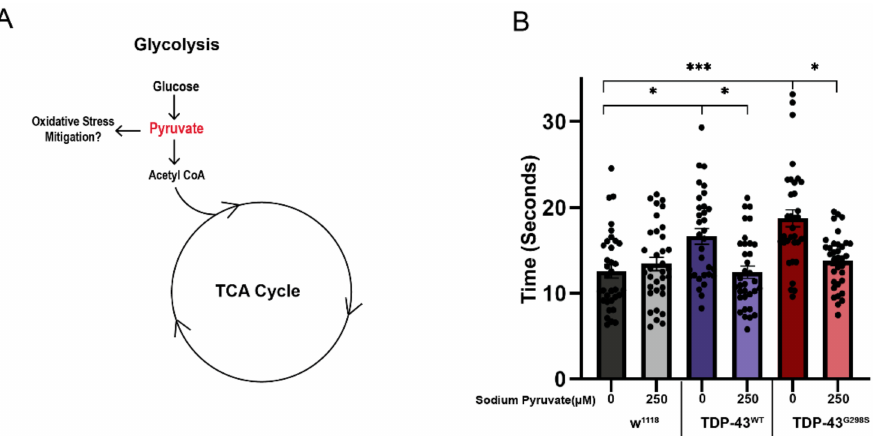
Figure 3. Dietary supplementation of pyruvate rescues TDP-43 induced locomotor defects. ( A ) A flowchart showing potential pyruvate input into multiple metabolic pathways. ( B ) Larval turning assays for Drosophila expressing TDP-43 fed a cornmeal-based media supplemented with 250 µ M sodium pyruvate, as indicated on the x -axis. Genotypes and treatments are as indicated. n = 30 larvae per treatment/per genotype. Kruskal–Wallis test was used to determine statistical